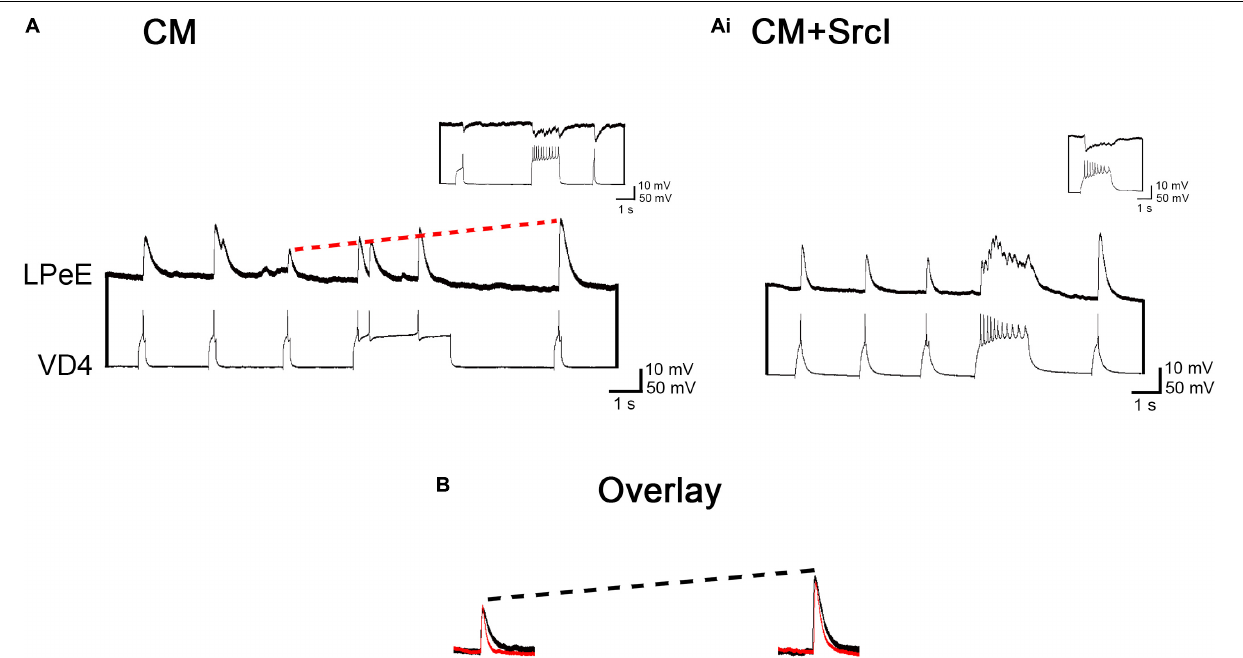
FIGURE 4 | Treatment of visceral dorsal 4 (VD4)–left pedal E (LPeE) soma–soma pairs with SrcI does not affect synapse formation, synaptic strength, or short-term potentiation (STP). (A) VD4–left pedal E (LPeE) pairs were cultured in a soma–soma configuration overnight in conditioned media (CM). Both cells were impaled with intracellular electrodes the next day to confirm that inhibitory synapses had formed. Pre- and post-tetanus reverse inhibitory postsynaptic potential (rIPSP) amplitudes were measured in LPeE (held at –100 mV for consistency). The red dotted line illustrates that post-tetanus rIPSPs were potentiated, on average, by 226%, compared to their pretetanus counterparts. Inset: action potentials triggered in VD4 induced an inhibitory response in LPeE when held at –60 mV (above the reversal potential for Cl − ), confirming the presence of an inhibitory synapse. (Ai) A separate group of VD4–LPeE pairs were cultured in CM + SrcI (5 µ M) overnight. Pre- and post-tetanus rIPSP amplitudes were measured the next day. Post-tetanus rIPSPs were potentiated, on average, by 196%. Inset: action potentials triggered in VD4 induced an inhibitory response in LPeE when held at –60 mV (above the reversal potential for Cl − ), confirming the presence of an inhibitory synapse. (B) Overlay of pretetanus rIPSPs (left) and potentiated post-tetanus rIPSPs (right) in control and SrcI-treated cell pairs. Black = control. Red = SrcI. Neither synaptic strength ( p = 0.545) nor STP ( p = 0.542) were affected by treatment with SrcI, as determined using a multivariate ANOVA (CM: n = 6; SrcI: n =